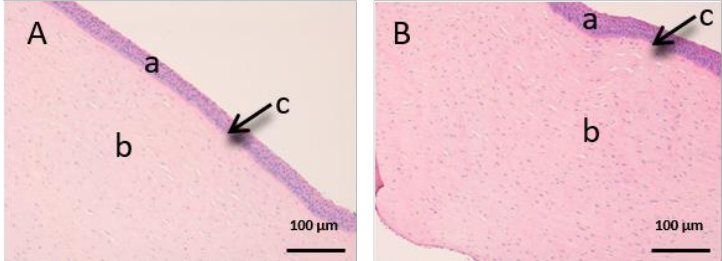
Figure 8. Histological images of sublingual mucous. ( A ): Untreated sublingual mucous observed at 400× and ( B ): Sublingual mucous treated with CP-Sat observed at 400×; a: stratified flat keratinized epithelium; b: own laminate; c: basal layer; d: muscle and e: collagen fibers.